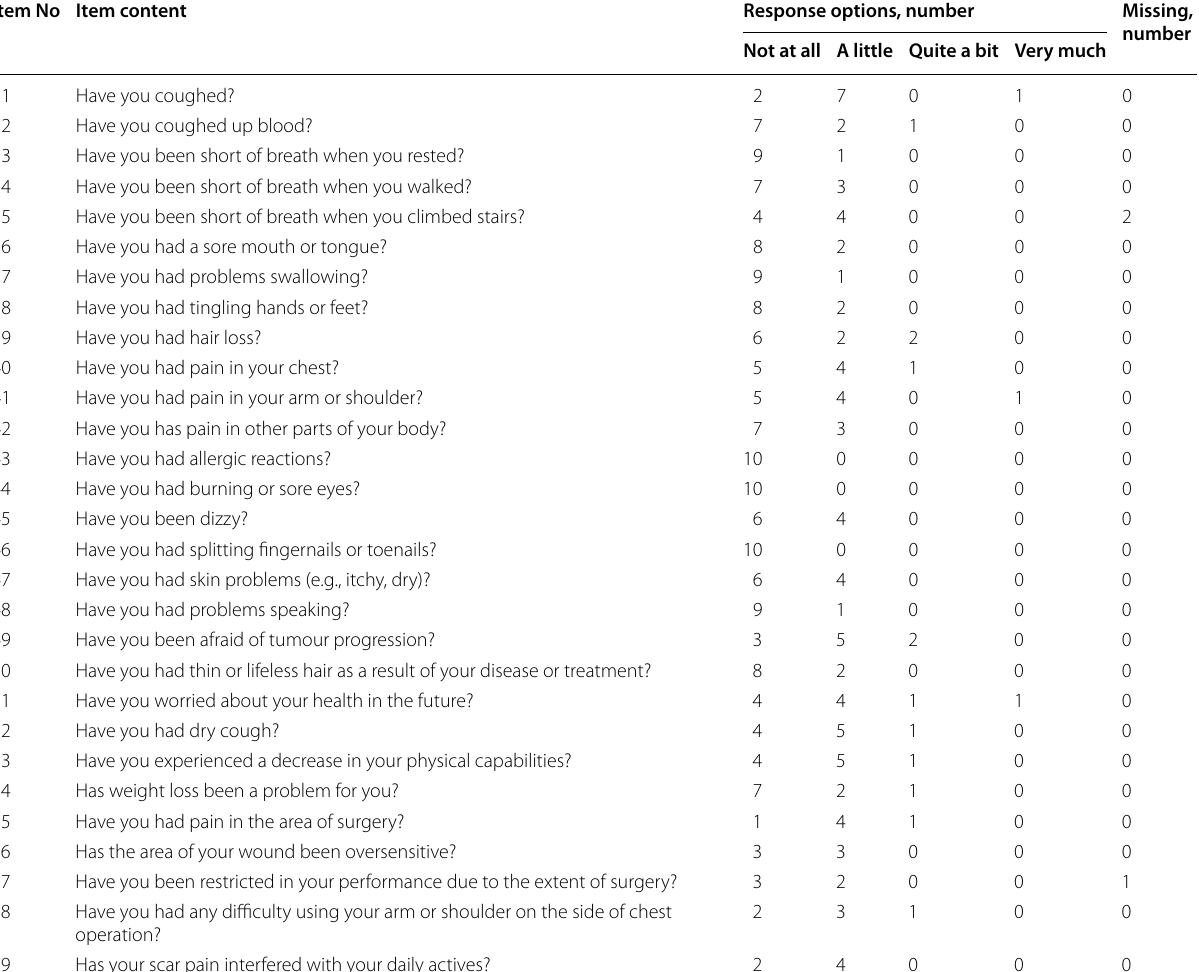
Table 3 Quantitative results of pilot